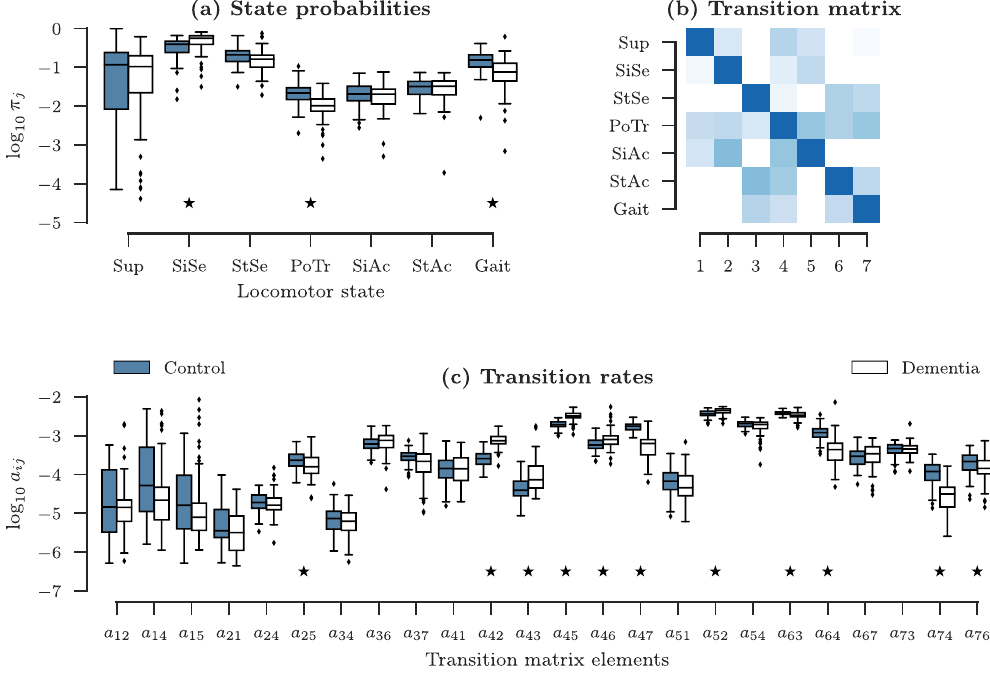
Figure 1. Summary statistics of features. The summary statistics of the two feature sets SP and TR are shown in this figure. Panels (a and c) show the box plots for SP and TR respectively for the two groups (control in dark, and dementia in white). The states and transitions at which the two groups differ significantly, calculated through the Mann-Whitney U-test ( p < 0.001), have been highlighted using black stars. The panel (b) displays an empirically constructed transition matrix representative of the control group subjects. The dark pixels represent higher transition rates, the shade lowering with decreasing transition rate. The null transitions are shown in white. The y -axis of the transition matrix represents the numerical coding of the seven states for clarity in interpreting the transition matrix elements (Sup corresponds to state 1, and Gait to state 7). In the panel (c), diagonal elements and the null transition elements have been dropped to preserve visual clarity. Also, all quantities have been plotted on a logarithmic (base-10) scale to highlight the distributional variations amongst the